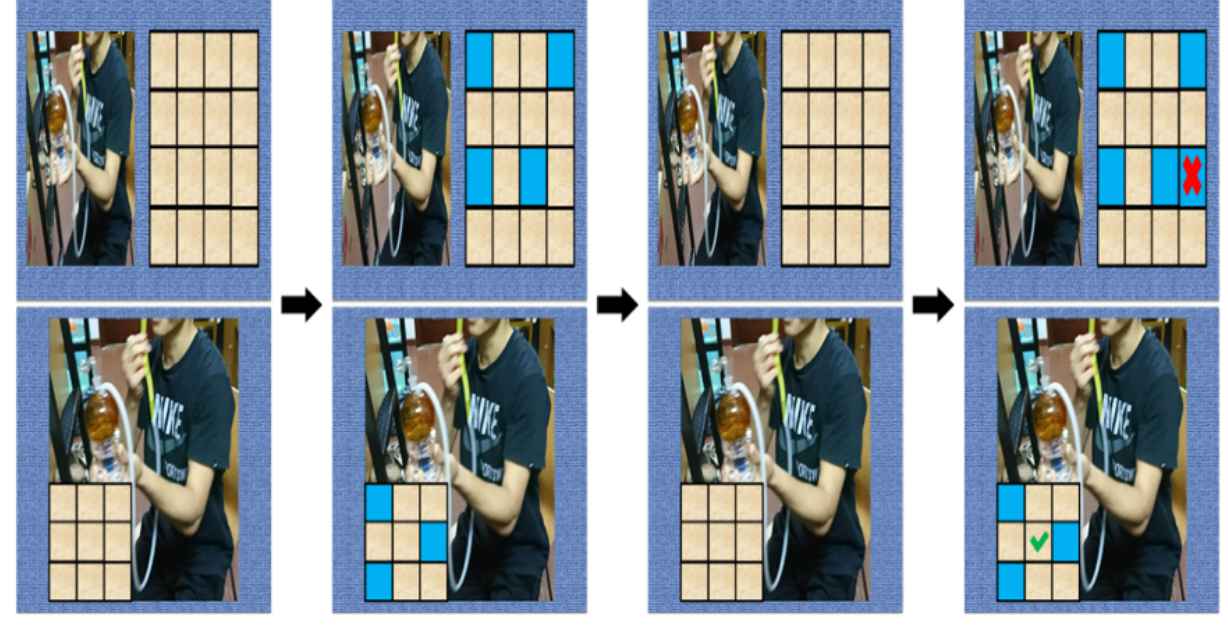
Figure 4. Memory matrix task. A few blue squares were shown for 3 seconds and then they disappeared and returned to the original color. Patients were told to indicate the squares that turned blue that were shown seconds before. An incorrect response resulted in a red cross, whereas a correct response resulted in a green checkmark.